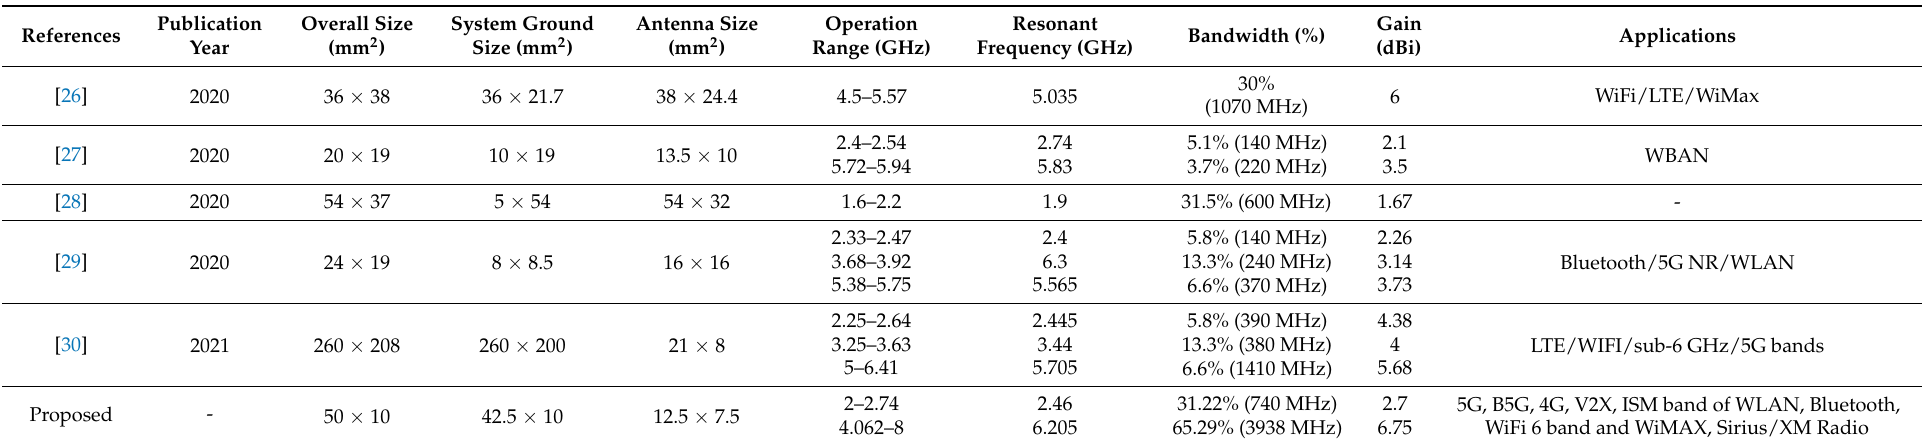
Table 1. Comparison of the proposed antenna with other research